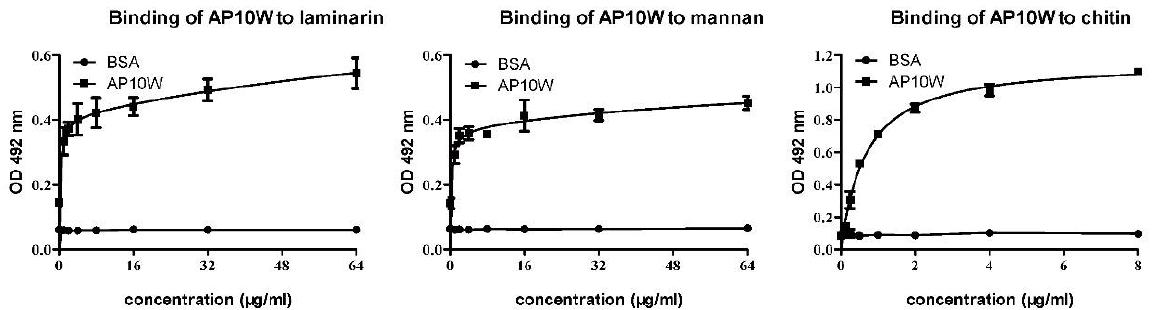
Figure 5. ELISA analysis of the affinity of AP10W to the laminarin, mannan and chitin. BSA served as control. Data are shown as means ± SD (n = 3). OD, optical density. The data are from three independent experiments performed in triplicate.